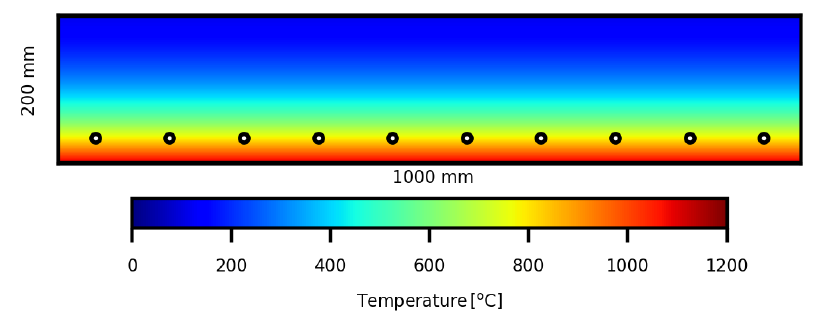
Figure 1. Temperature field of a 20 cm thick concrete slab with the concrete cover of 35 mm after 120 min of standardized fire